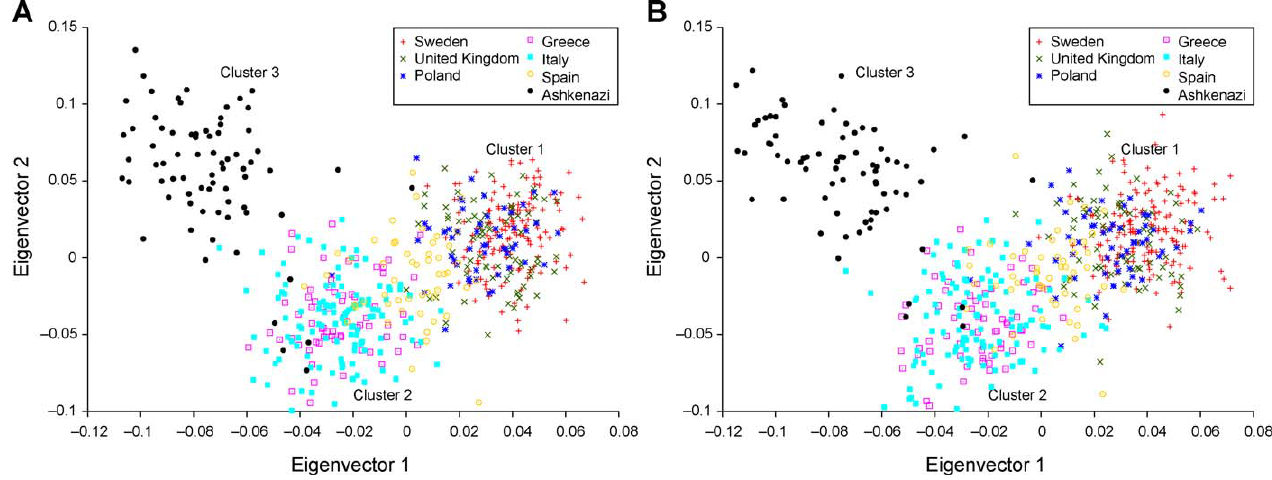
Figure 3. The Top Two Axes of Variation of a Dataset of Diverse European Samples Results are based on (A) 583 markers putatively ancestry-informative markers, and (B) 300 validated markers.